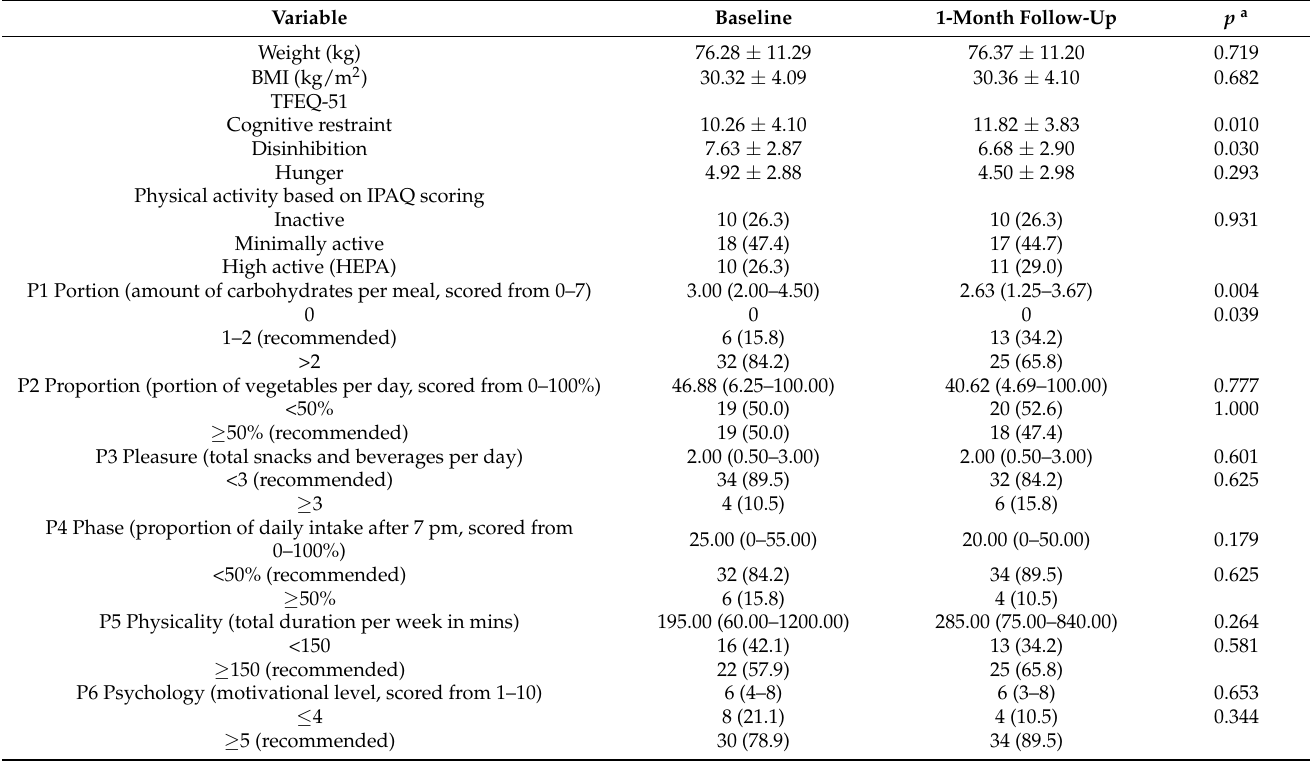
Table 3. Weight, eating behavior, physical activity, and 6P assessment at baseline and one-month follow-up ( n =